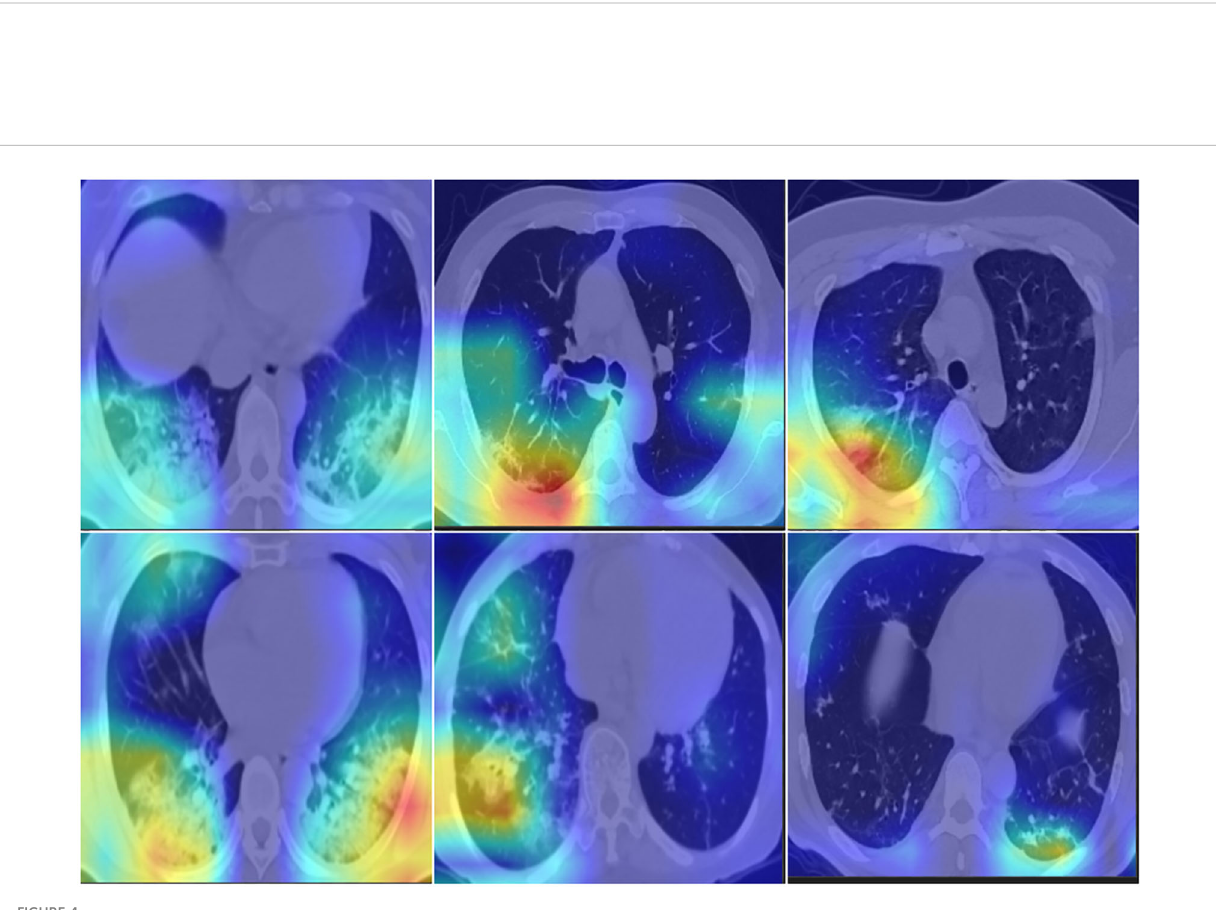
FIGURE 4 Fusion images with Grad-CAM, which indicate the import region for classi fi cation. First row are normal cases, second row are COVID-19 cases. RGB color indicate the high risk for suspects, light color indicate the normal region.